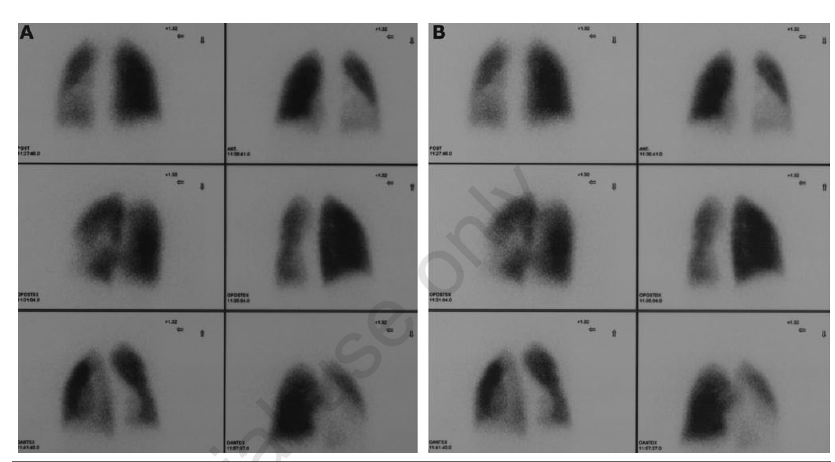
Figure 1. Pulmonary perfusion scintigraphy before (A) and 1 year after BMT (B)